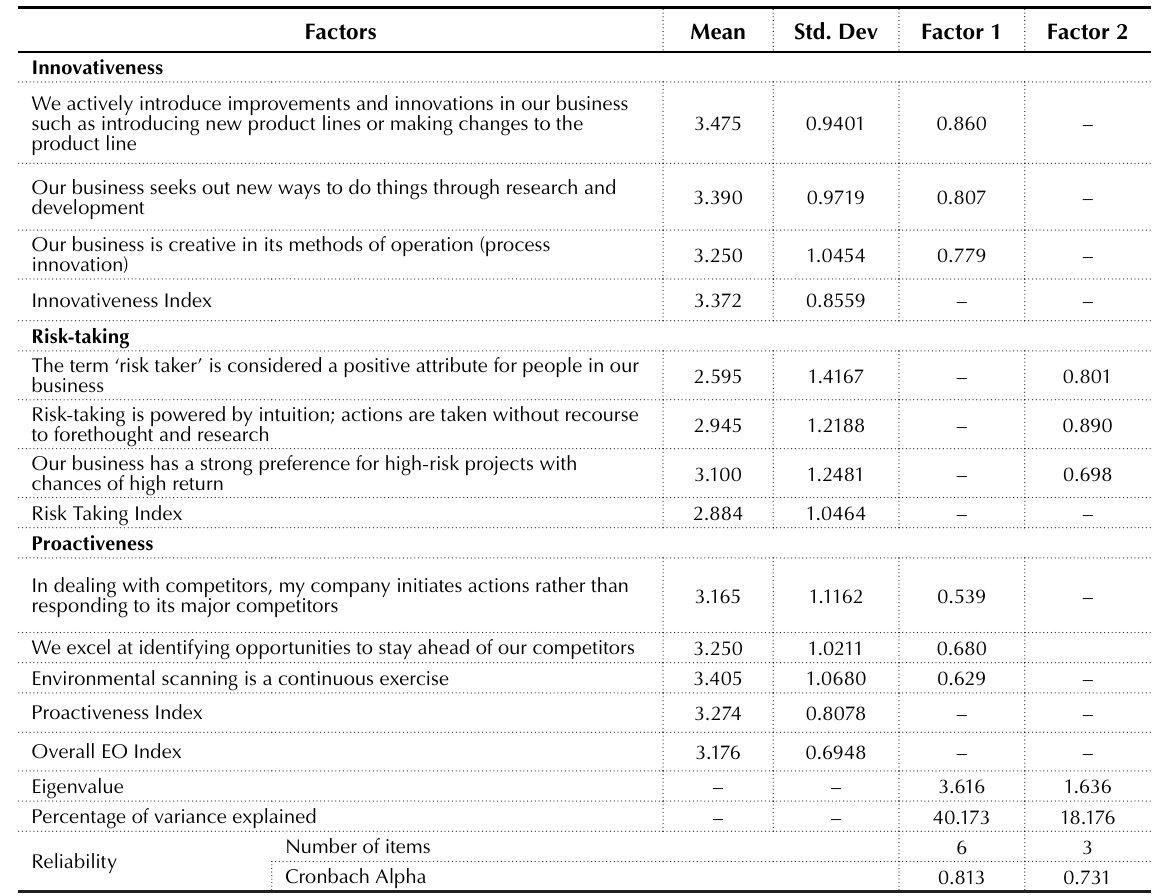
Table 1. Descriptive statistics for EO dimension items and EO